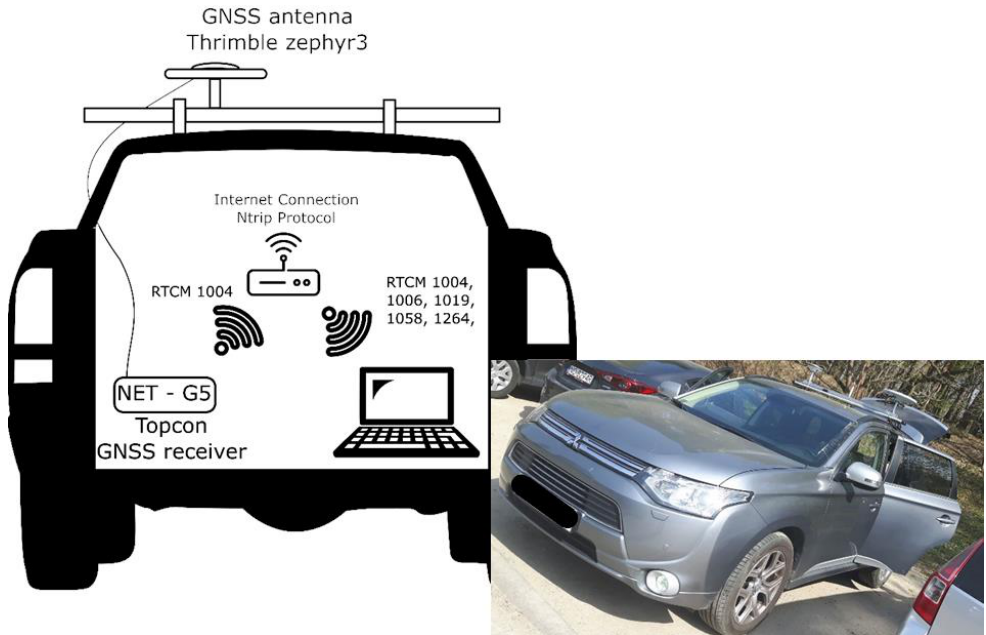
Figure 3. Car setup configuration during the test drive.